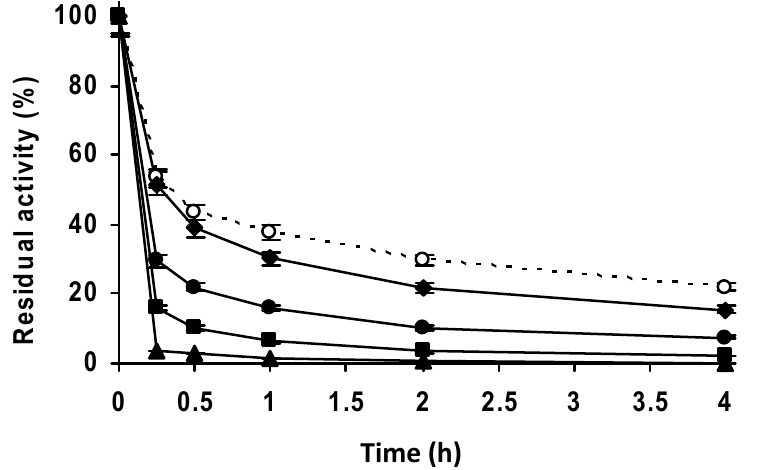
Figure 9. Thermal inactivation courses of PGA immobilized at pH 7.0 in 1 M sodium sulfate and incubated at different pH values (compared to the enzyme immobilized on glyoxyl agarose. The incubation time was 3 h and the biocatalysts were blocked with 2 M glycine. Empty circles with dashed line: glyoxyl agarose-PGA. Full triangles with solid line: sodium phosphate at pH 7.0. Full squares with solid line: sodium phosphate at pH 8.0. Full circles with solid line: sodium carbonate at pH 9.0. Full rhombi with solid line: sodium carbonate at pH 10.0. Other specifications are described in the